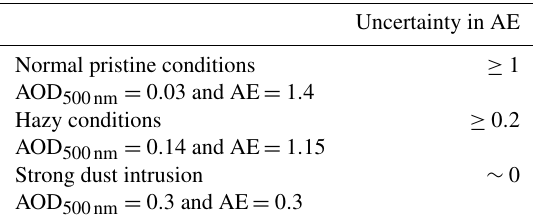
AE ≥ 1, the AE differences can reach a maximum of 1.6. Table 11. Uncertainty in AE determination for three typical atmo- spheric